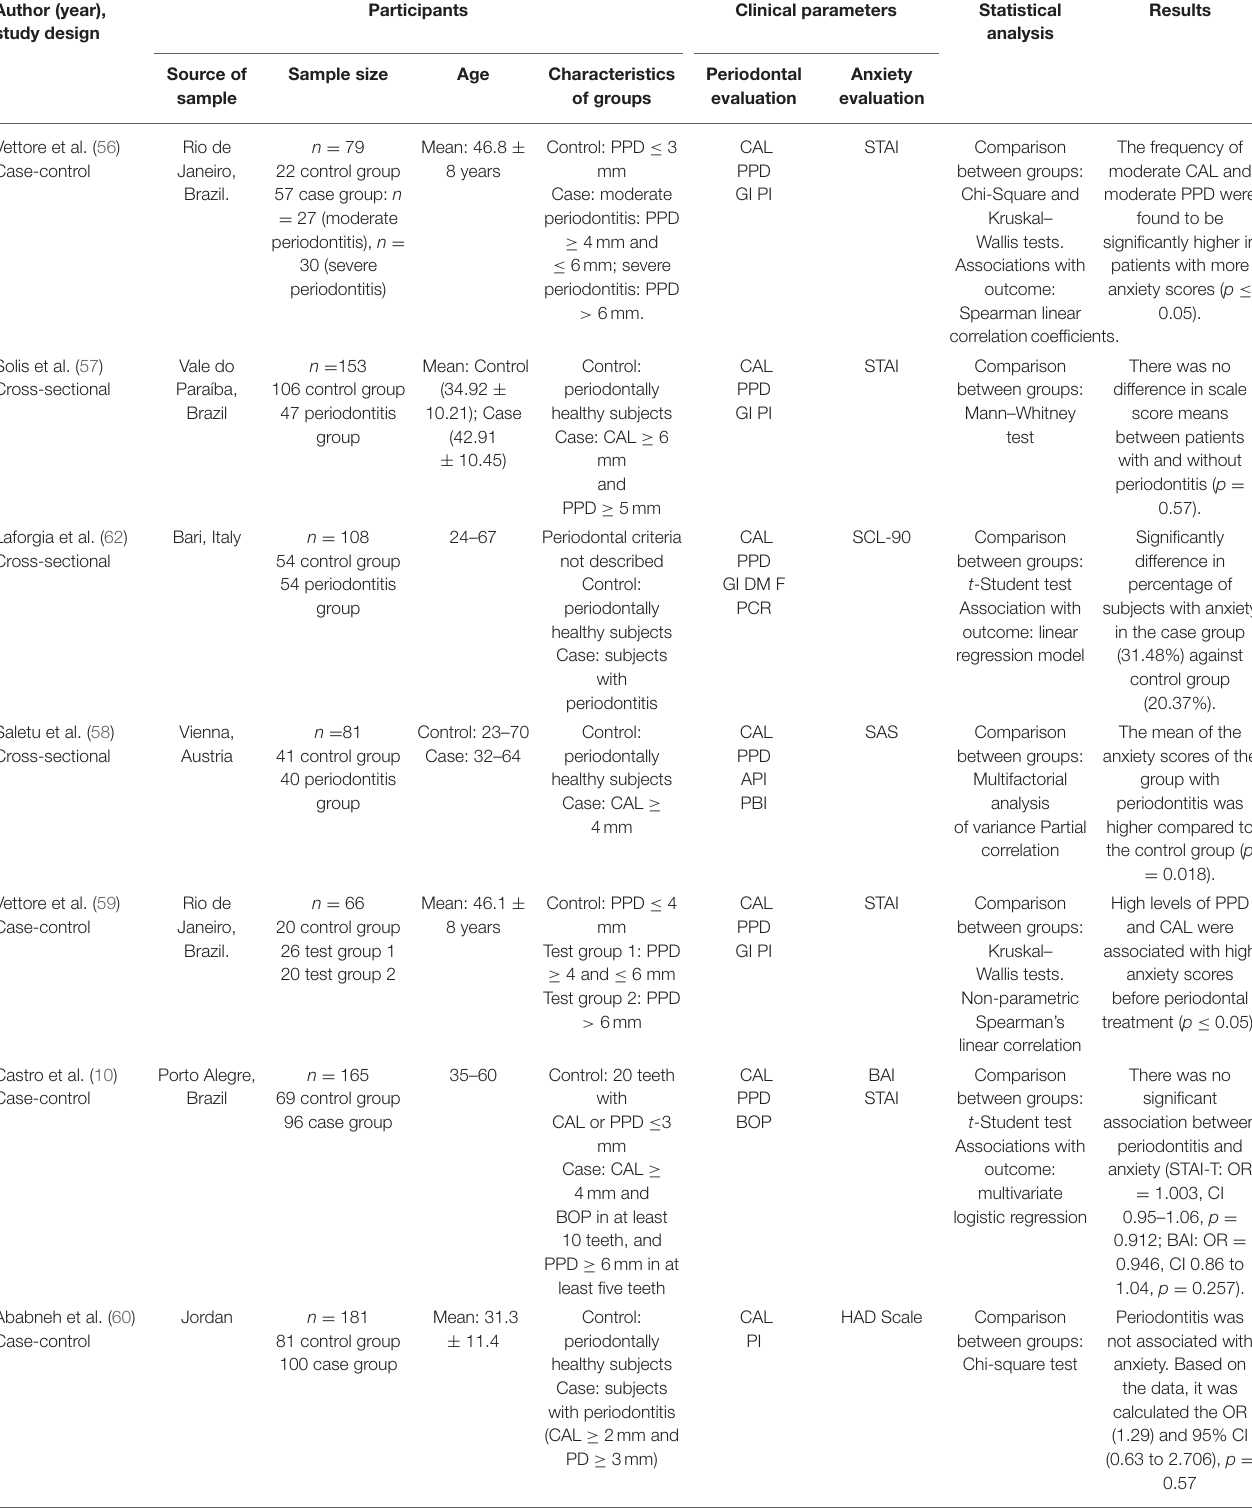
TABLE 1 | Characteristics of the included